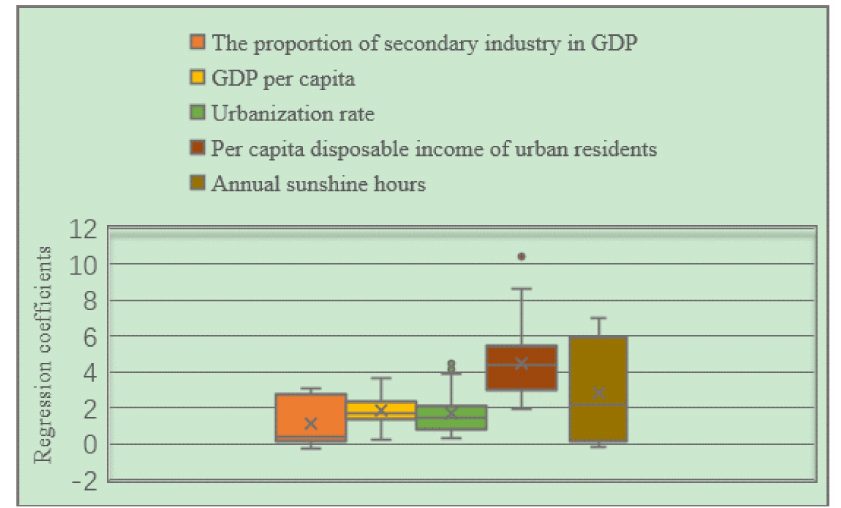
Figure 17. Box plot of GWR model regression coefficient distribution of EPC in the three major urban agglomerations of the YREB in